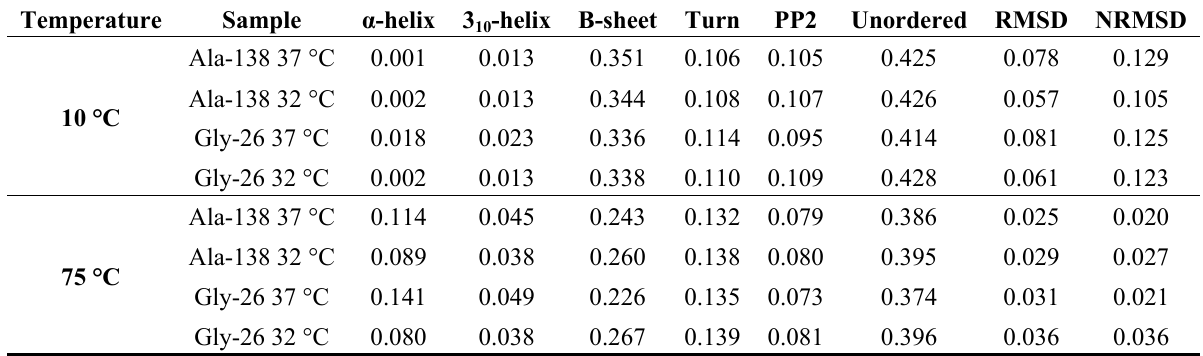
Table 3. Secondary structure estimation from CD data of native and denatured